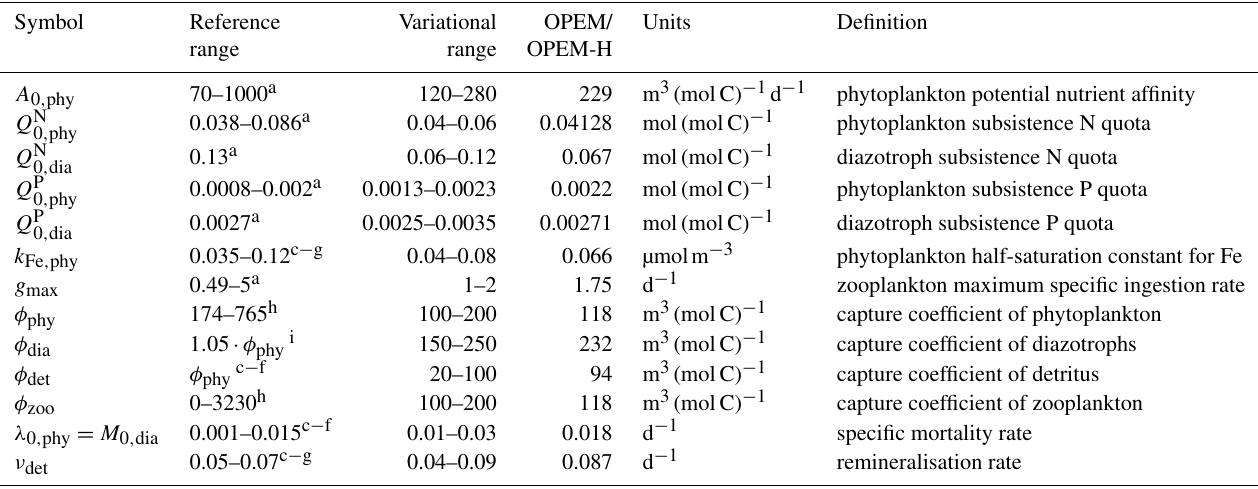
Table 1. Parameter names, reference and variational ranges, identified “best” values for the trade-off simulations (OPEM and OPEM-H), units, and definitions. Note that the trade-off simulations share the same parameter